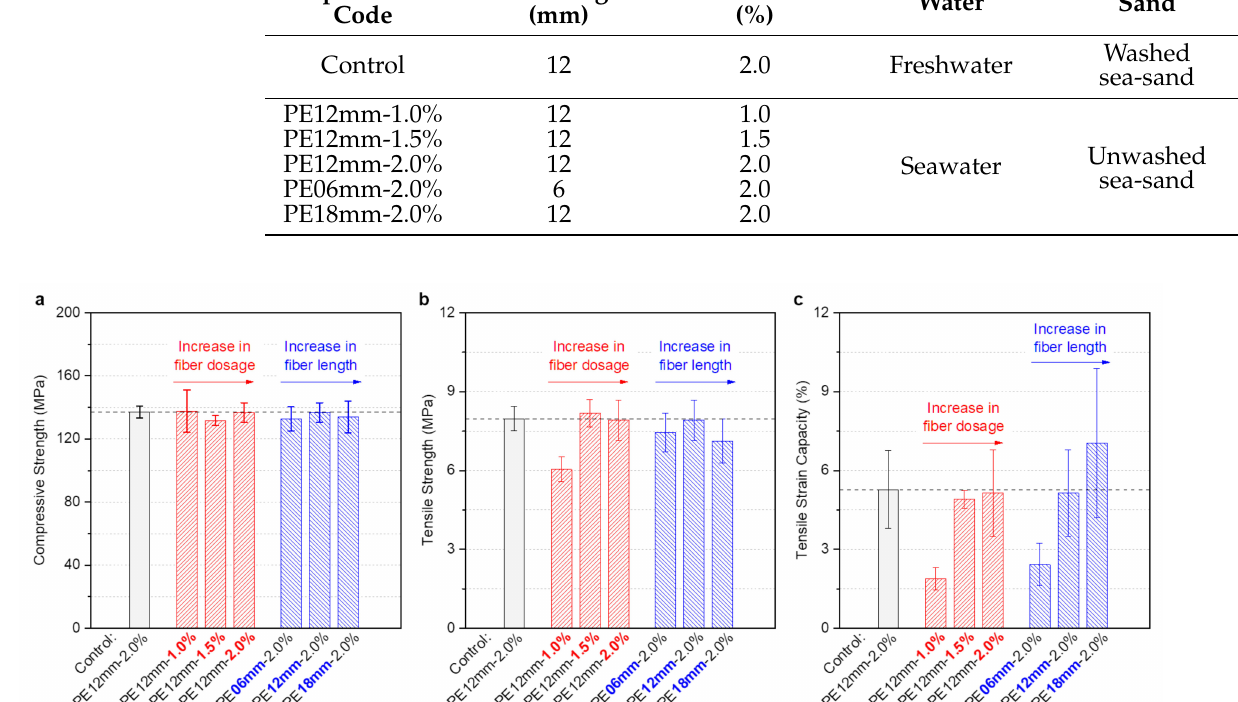
Figure 6. Mechanical properties of SS-UHPC: ( a ) compressive strength; ( b ) tensile strength; and ( c ) tensile strain capacity